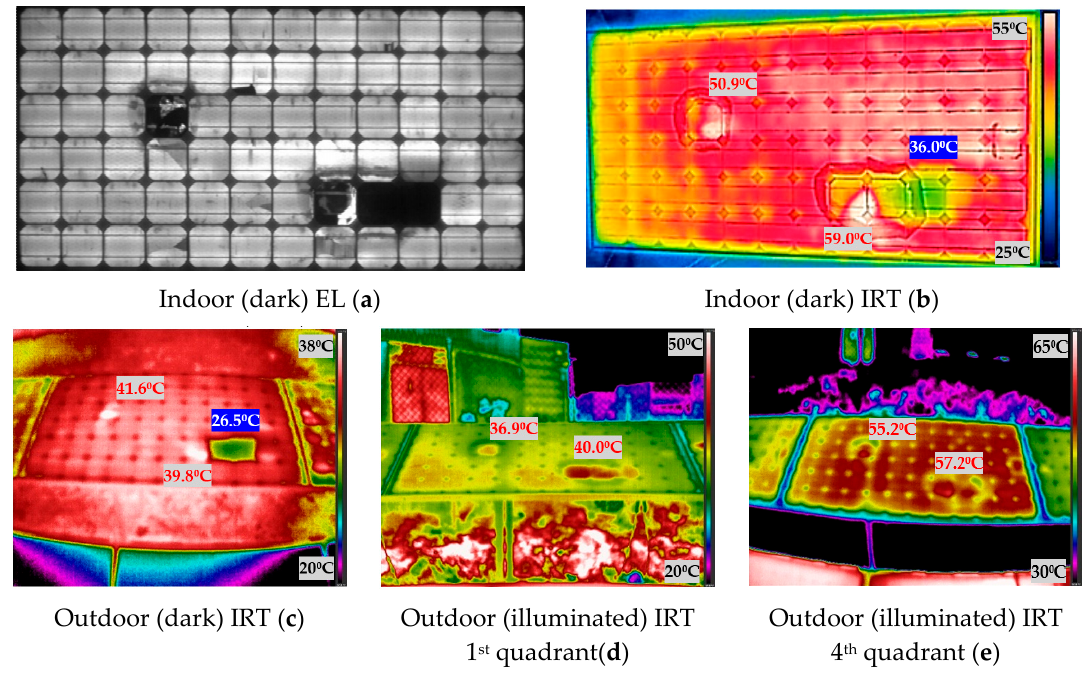
Figure 11. Indoor and outdoor characterization images of module 3: ( a ) indoor (dark) EL; ( b ) indoor (dark) IRT; ( c ) outdoor (dark) IRT; ( d ) outdoor (illuminated) IRT first quadrant; ( e ) outdoor (illuminated) IRT fourth quadrant.